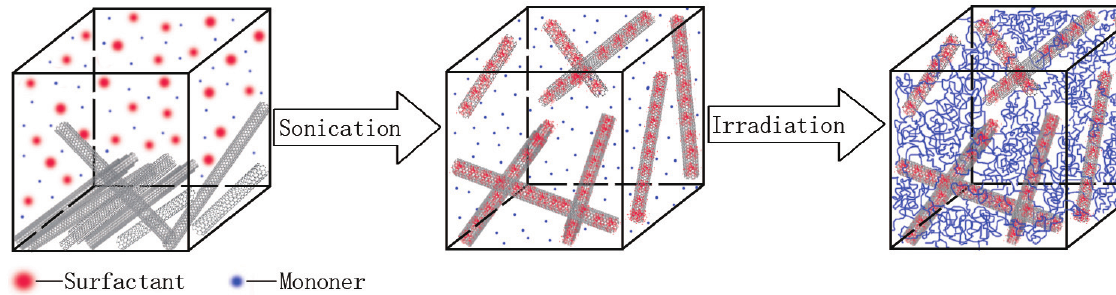
(Figure S1). The addition of AAm aqueous solution into the dispersion did not induce the sedimentation of MWNTs.